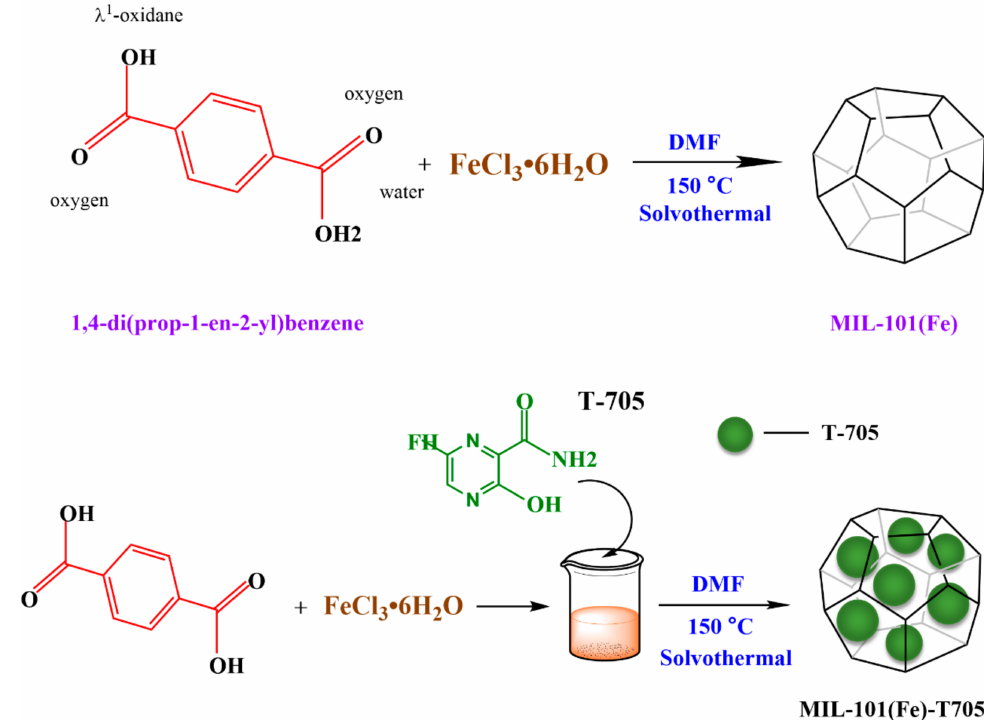
Figure 1. Synthetic schematic diagram of MIL-101(Fe) and MIL-101(Fe)-T705. We compared the UV-Vis absorption spectra of MIL-101(Fe)-T705, MIL-101(Fe), and T-705, and analyzed the preparation of MIL-101(Fe)-T705 at different temperatures and different favipiravir dosages, with dimethyl sulfoxide (DMSO) as the reference material. The absorption peak of MIL-101(Fe)-T705 was around 260 nm, consistent with MIL-101(Fe), and the absorption peak became higher and wider, covering T-705 (Figure S5A). Similarly, as shown in Figure S5B, the half-peak width of the absorption peak of nanoparticles also gradually shrank and narrowed with the increasing reaction temperature, which can be explained by the fact that at 150 ◦ C, the obtained uniform dispersion of the nanoparticle size was improved. MIL-101(Fe)-T705 had significant absorption in the UV region in the wavelength range of 200–350 nm (Figure S5C). At 0.1% MIL-101(Fe)-T705, the half-peak width was the narrowest and, with the increasing concentration of T-705, the half-peak width increased until 0.8% MIL-101(Fe)-T705. The highest absorption peak was seen at this time. However, there was no longer a significant absorption peak at 1% MIL-101(Fe)-T705. This can be explained by the increasing concentration of T-705, which resulted in the pore structure of the loaded MIL-101(Fe) not being uniform. Therefore, we concluded that the 0.8% concentration of T-705 was most suitable for binding with MIL-101(Fe) to become